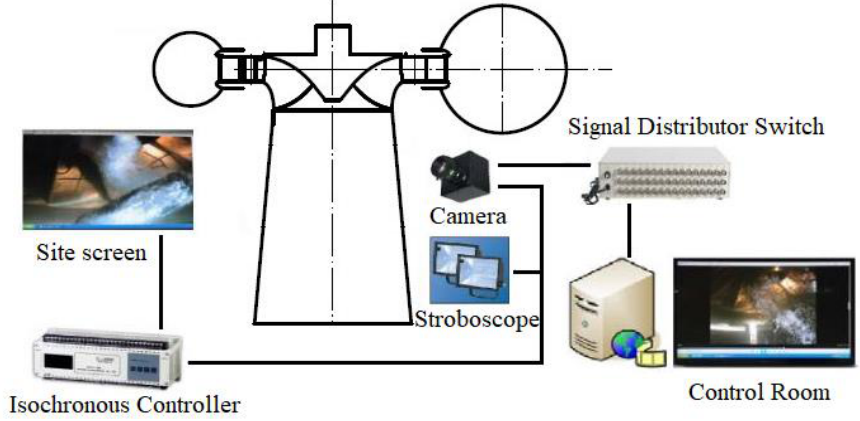
Figure 5. Sketch of flow pattern observation system.